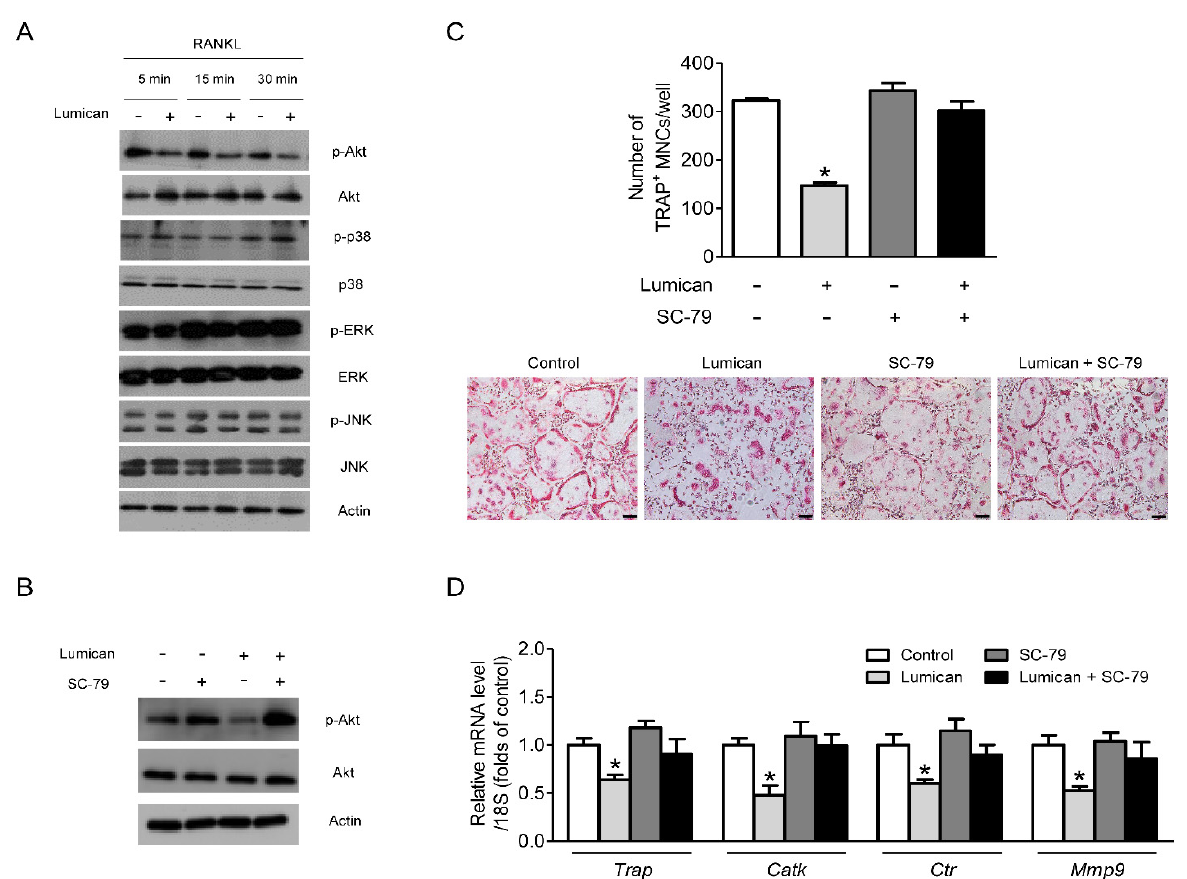
Figure 3. Suppression of the Akt signal mediates the effects of lumican on osteoclastogenesis. ( A ) Western blot to assess RANKL-dependent phosphorylation of downstream kinases in mouse BMMs after exposure to 10 nM lumican and 30 ng/mL RANKL following culture for 3 days in the presence of 30 ng/mL M-CSF ( n = 5). ( B ) Western blot analysis to assess the phosphorylation of Akt in mouse BMMs after exposure to 30 ng/mL RANKL, 10 nM lumican, and 2 µ g/mL SC-79 (Akt activator) following culture for 3 days in the presence of 30 ng/mL M-CSF ( n = 3). ( C , D ) Primary mouse BMMs were co-treated with 30 ng/mL RANKL, 30 ng/mL M-CSF, 10 nM lumican, and 2 μ g/mL SC-79 for 4 days ( n = 4). ( C ) After the cells were stained with TRAP, the number of TRAP-positive multinucleated cells (MNCs) ( ≥ 3 nuclei/cell) was determined to assess osteoclast differentiation. ( D ) Quantitative RT-PCR analysis was performed to determine the levels of osteoclast differentiation markers. Scale bars: 100 μ m ( C ). Data are means ± SEM. * p < 0.05 vs. untreated control.